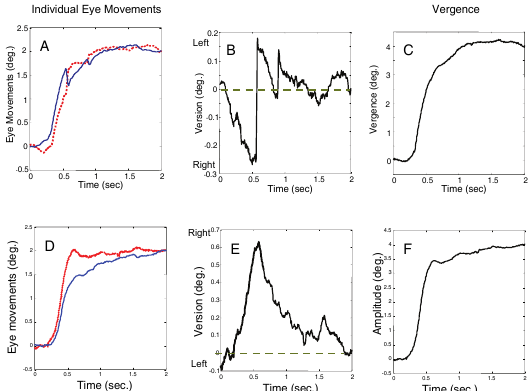
Figure 4 Responses follow the same nomenclature as Figure 3. In these responses, a fast disparity vergence asymmetry creates the symmetry error. A) and D) Individual right (red) and left (blue) eye movements. B) and E) The version component. In B, two saccades appear to be correcting the symmetry error produced by an initial fast disparity vergence asymmetry while in E the fast disparity vergence asymmetry is corrected by a compensatory vergence asymmetry. C and F) The vergence responses are again smooth due to either saccade cancellation (C) or the absence of saccades (F).